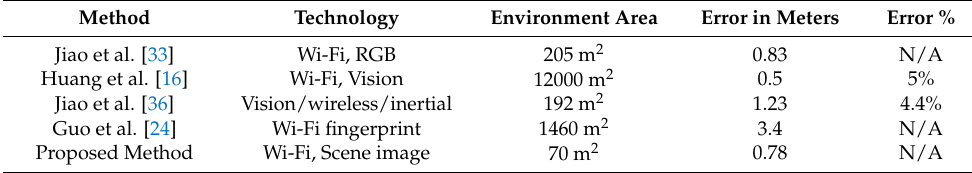
Table 4. Comparison of the proposed algorithm with established algorithms.